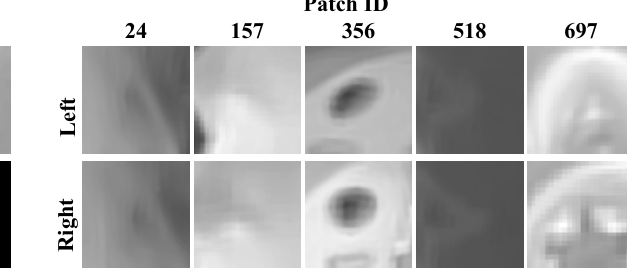
Figure 5. Examples of cropped images patches from ThermalPatches